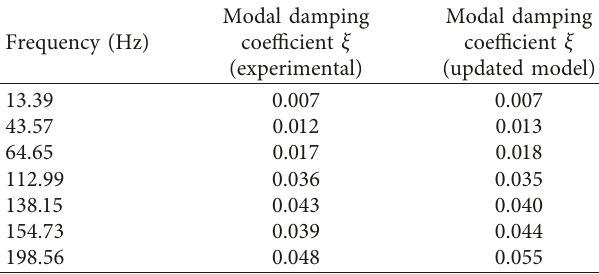
Figure 7: MAC matrix between the experimental modes and the updated model Table 5: Comparison of the experimental and analytical modal properties.